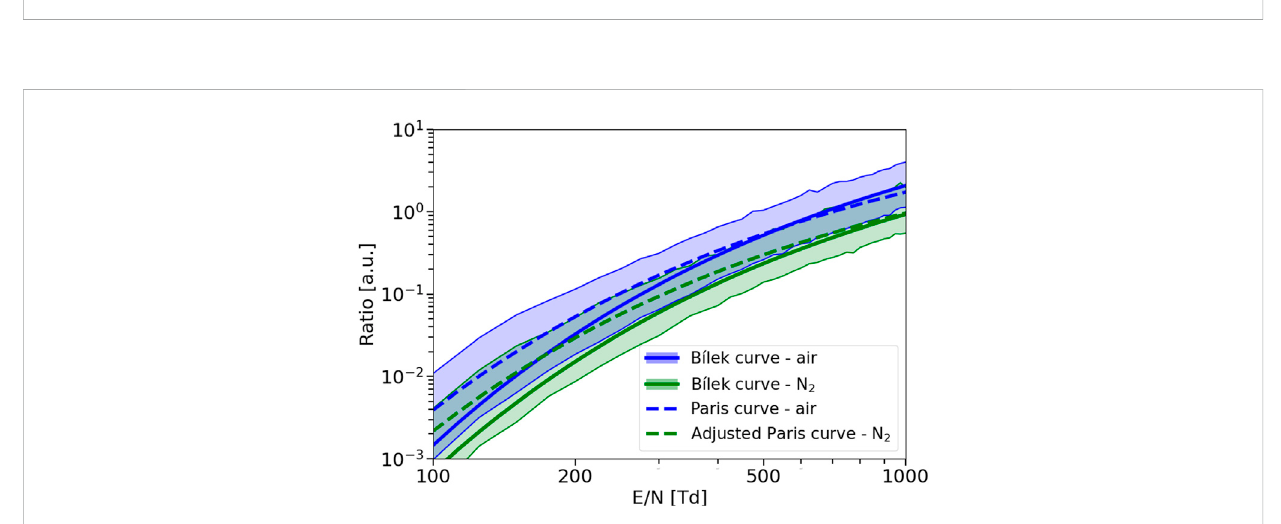
FIGURE 4 Fundamentals of the used intensity ratio method. (A) Energy diagram [23] for the most relevant electronic states of nitrogen with their vibrational levels, showing the pumping of the FNS and SPS upper states from the groundstate and their emissions. (B) Integral electron-impact excitation cross section [24] for the N 2 (C 3 Π u ) and N + 2 ( B 2 Σ + u ) electronic states, combined with the EEDF ’ s for various reduced electric fi eld strengths in 33 mbar pure nitrogen.